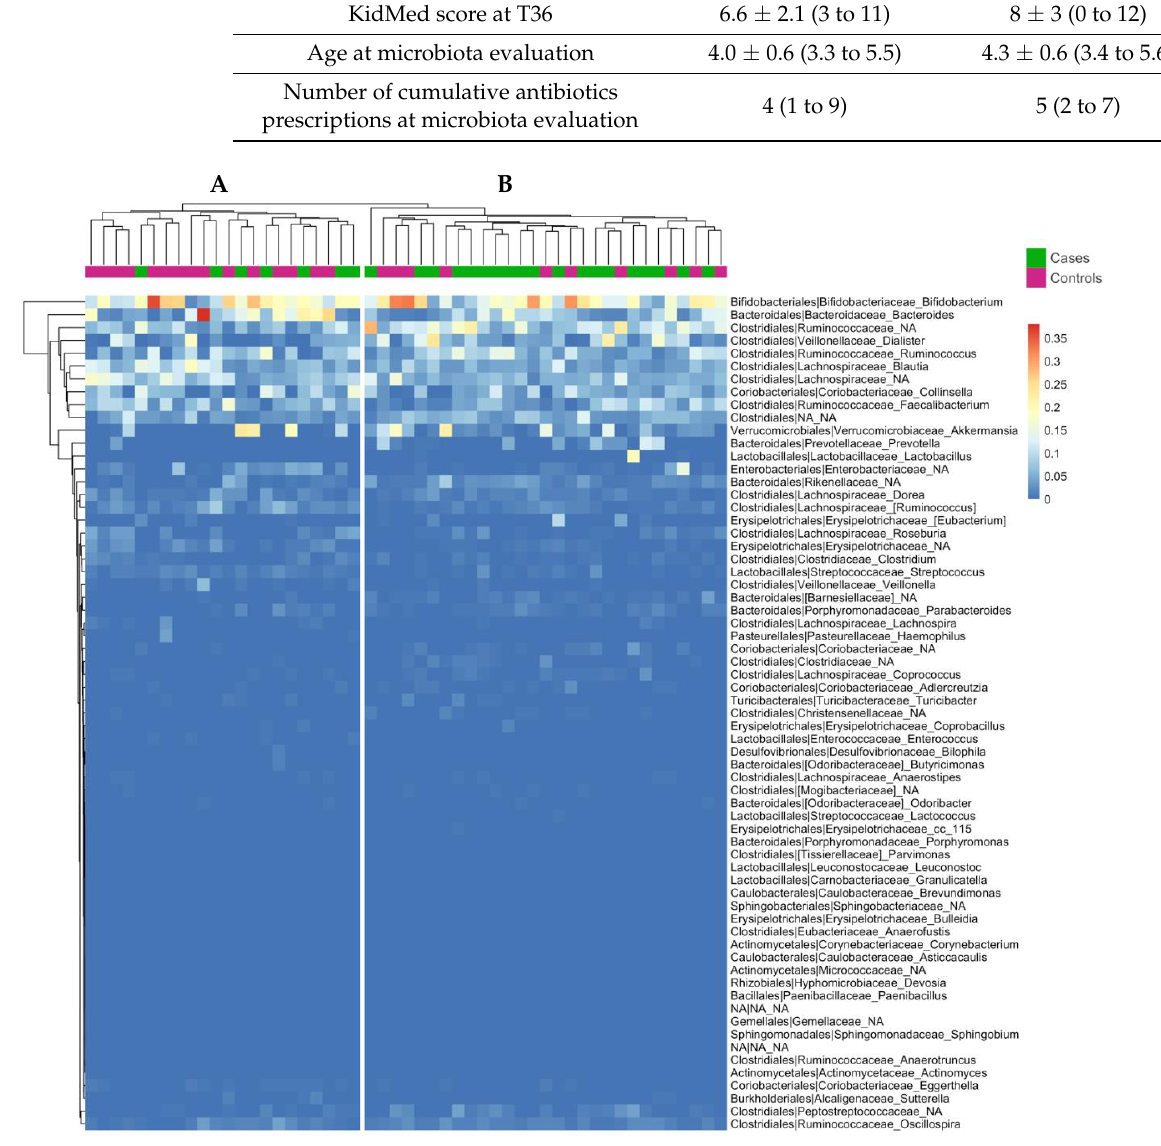
Figure 4. Complete linkage clustering of subjects based on gut microbiota composition at genus level. Only genera with a median absolute abundance >2% were considered. The Canberra metric was used to compute distance between each pair of subjects.